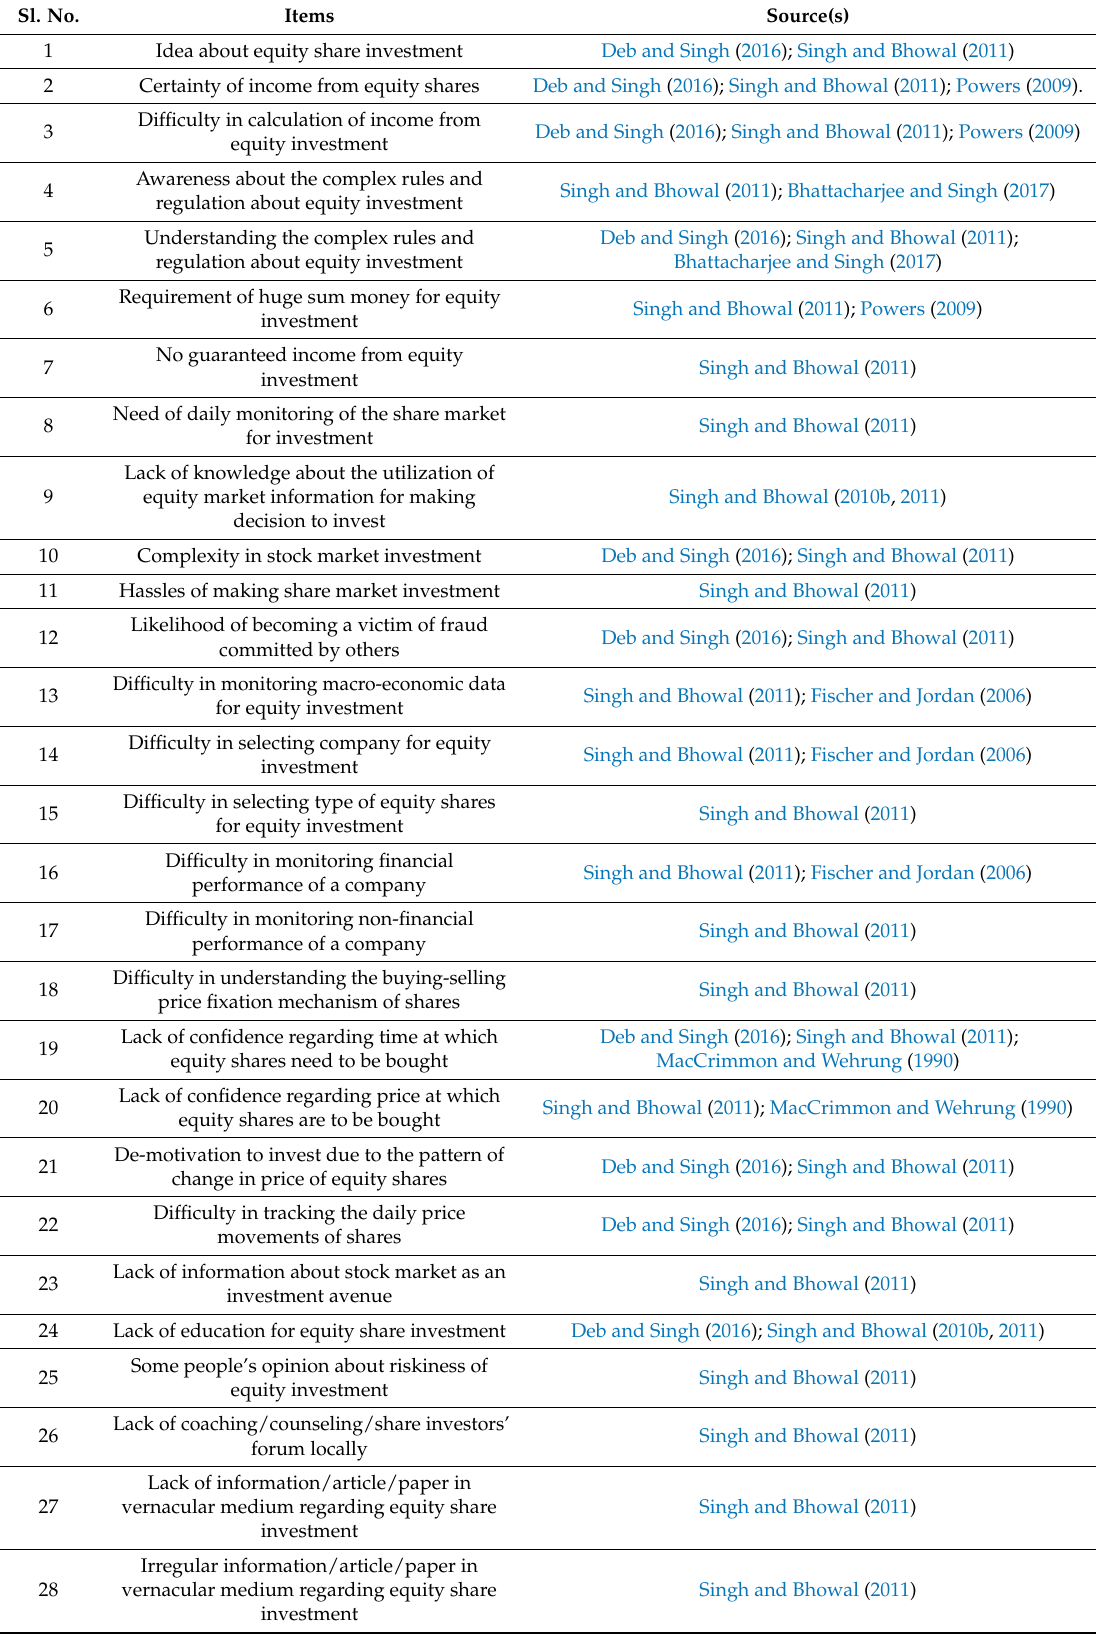
Table 1. Details of